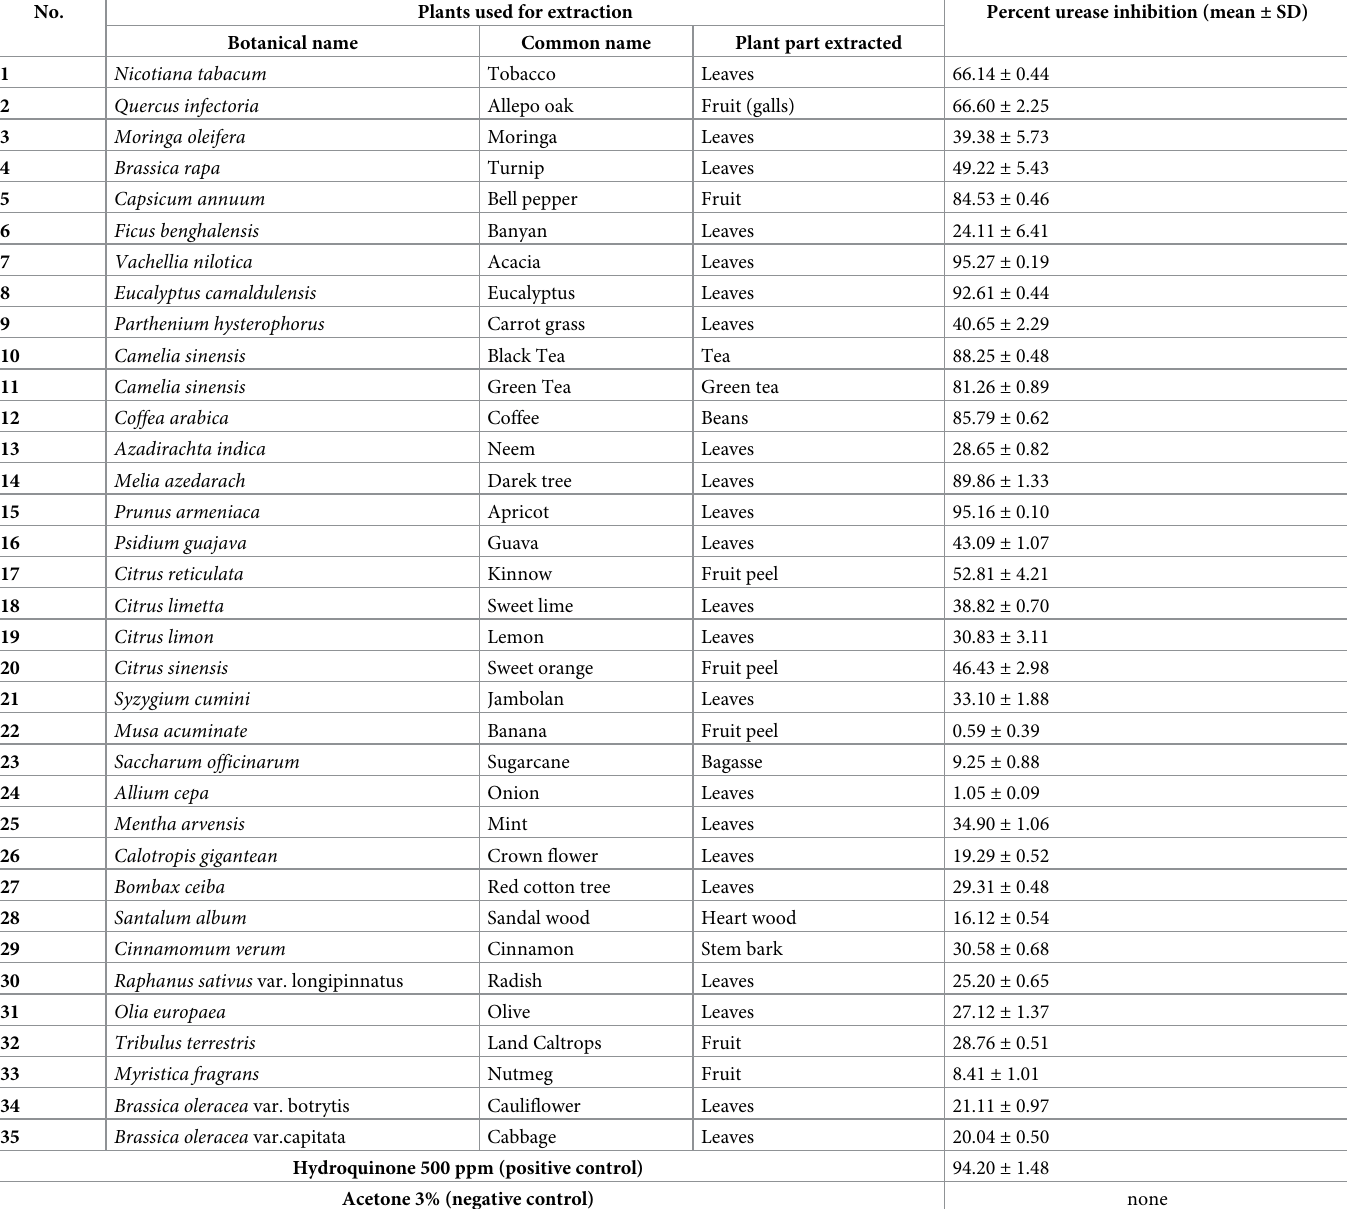
Table 1. Potential of 35 plant extracts to inhibit jack bean